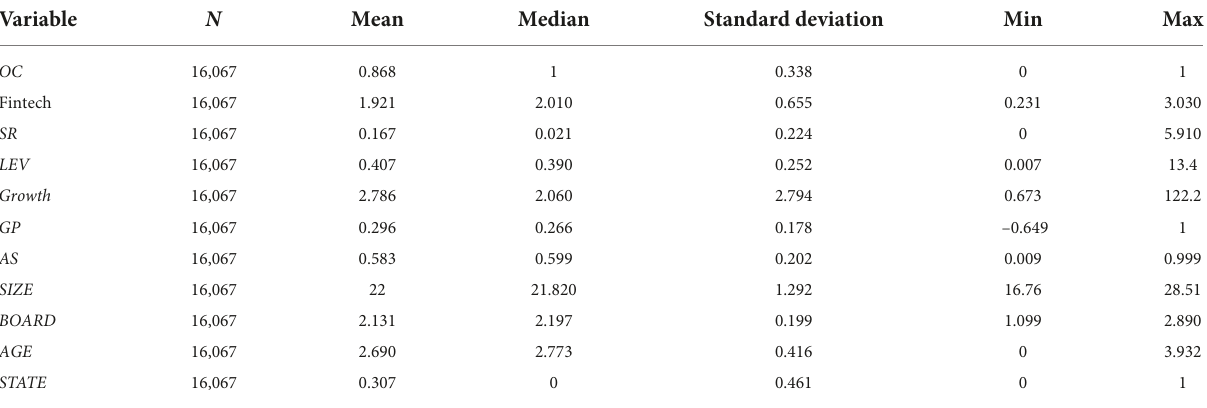
TABLE 2 Descriptive statistics of the main